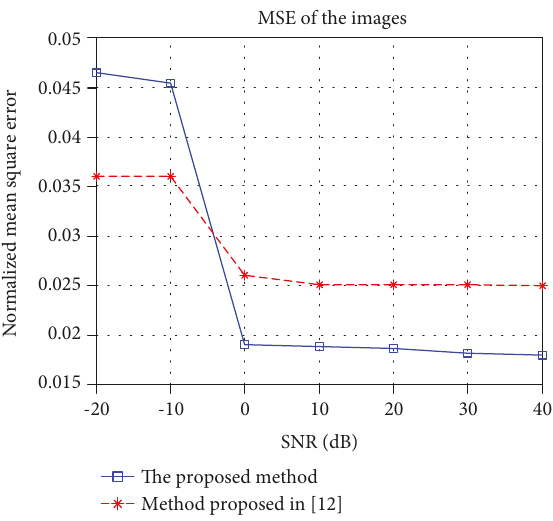
Figure 8: Mean square error of the